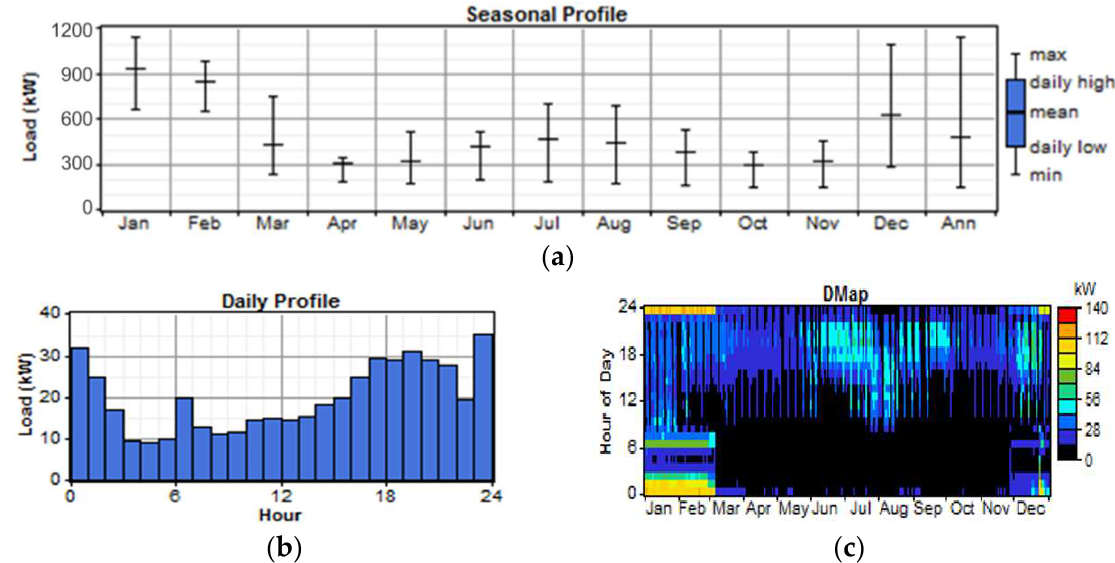
Figure 1. ( a ) Seasonal Load Profile; ( b ) Daily Load Profile; ( c ) Daily Load Map (time step: 1 h).